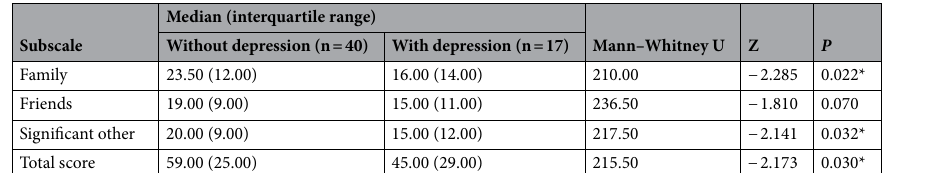
Table 6. Comparisons of MSPSS-C subscales and total score between people with stroke with depression (GDS-15-C score ≥ 8) and without depression (GDS-15-C score < 8). p < 0.05*.